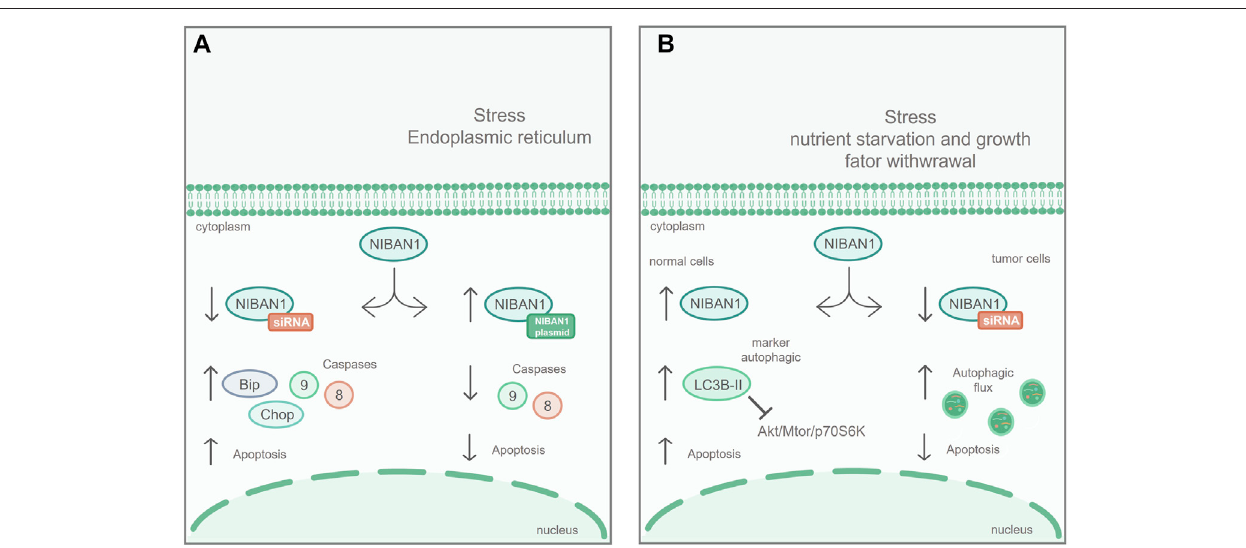
FIGURE3| NIBAN1 intheregulationofapoptosisandautophagy: (A) Apoptosis:Inrenalcelllines, NIBAN1 silencingincreasesstress-inducedapoptosisoftheER and promotes the expression of caspase 8, caspase 9, Bip, and Chop. On the other hand, overexpression of NIBAN1 reduces both stress-induced apoptosis and the expression of caspase 8 and caspase 9, suggesting that NIBAN1 may be involved in the regulation of apoptosis via caspase-dependent pathway. Modi fi ed fi gure from Tang et al. (2019). (B) Under nutritional restriction, in normal thyroid cell line, NIBAN1 expression is increased, together with LC3B-II, an autophagy marker, inhibiting the AKT/mTOR/p70S6K pathway, and increasing cell death. On the other hand, with NIBAN1 silencing, in thyroid cancer cell line, the autophagic fl ux is increased, suggesting that NIBAN1 can inhibit autophagy in these models, avoiding programmed cell death. Modi fi ed fi gure from Nozima et al. (2019).